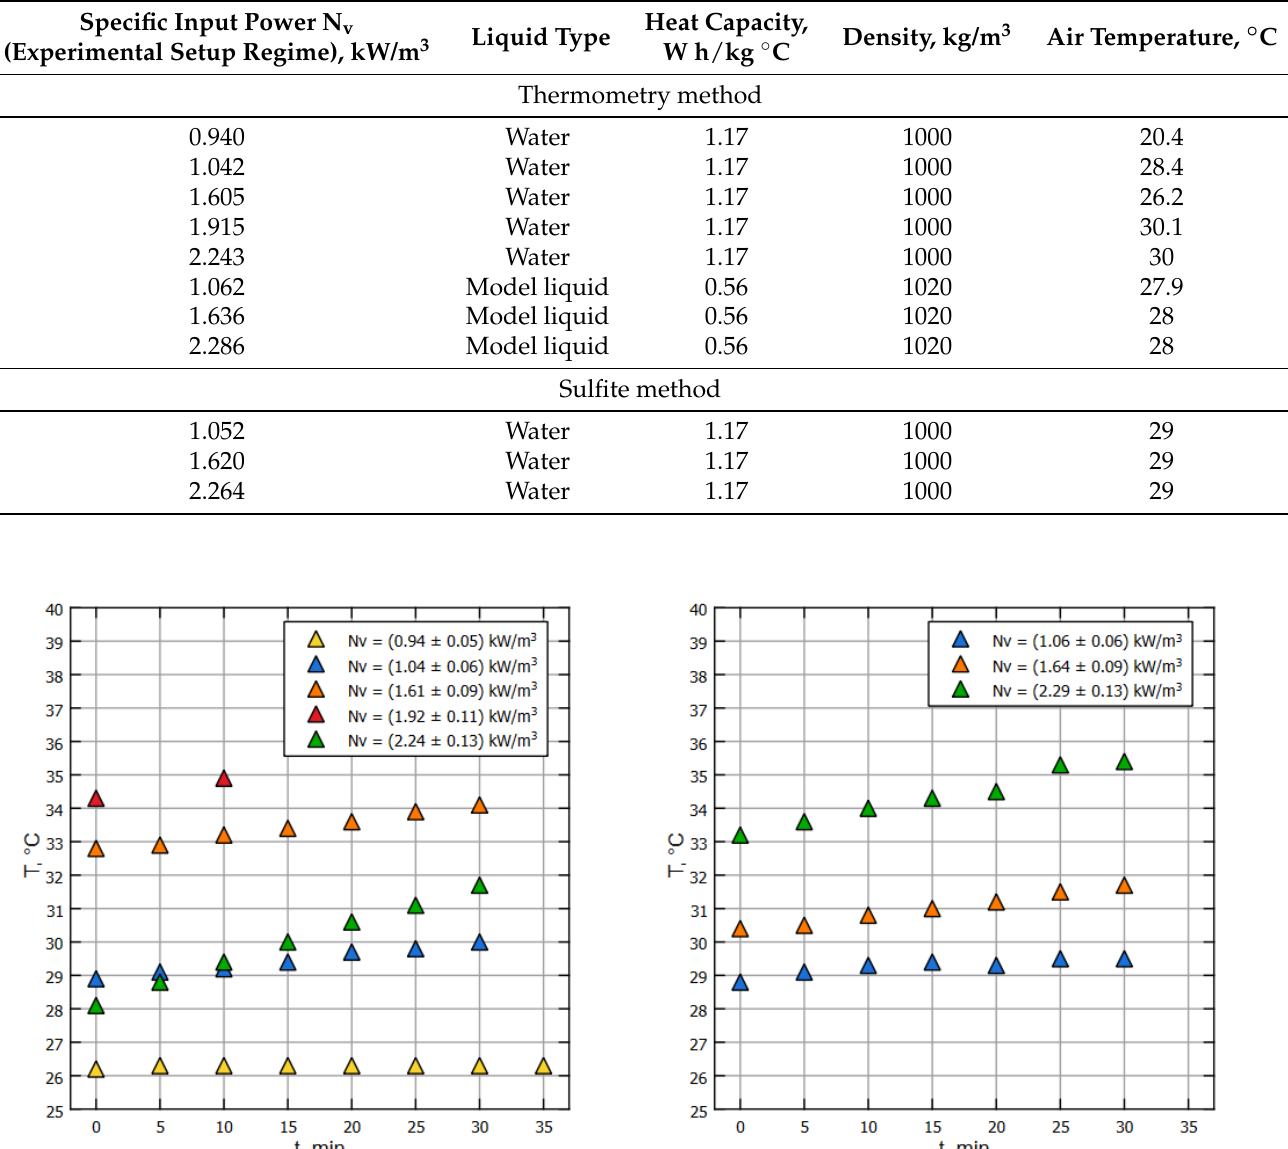
Table 1. Experimental media and hydrodynamic regimes parameters.